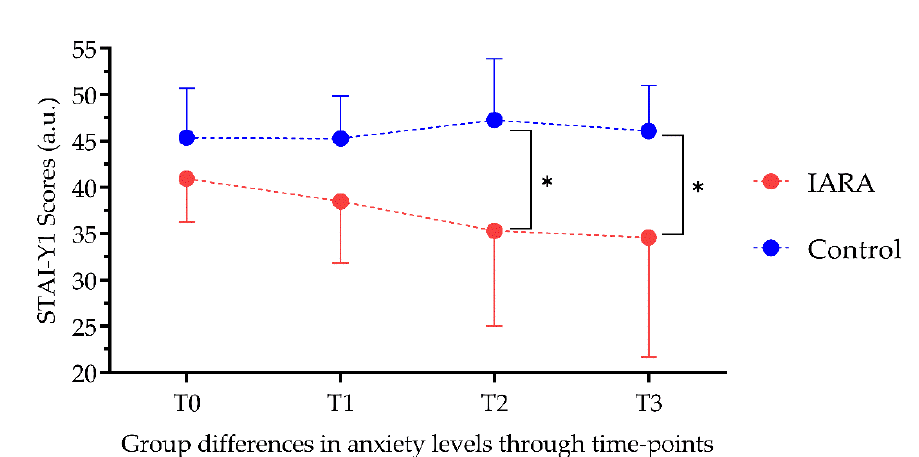
Figure 3. State anxiety was significantly reduced in people who followed the IARA model. STAI-YI— State Anxiety Scale; T0—baseline; T1—3-month follow-up; T2—6-month follow-up; T3—12-month follow-up; *— p < 0.05.